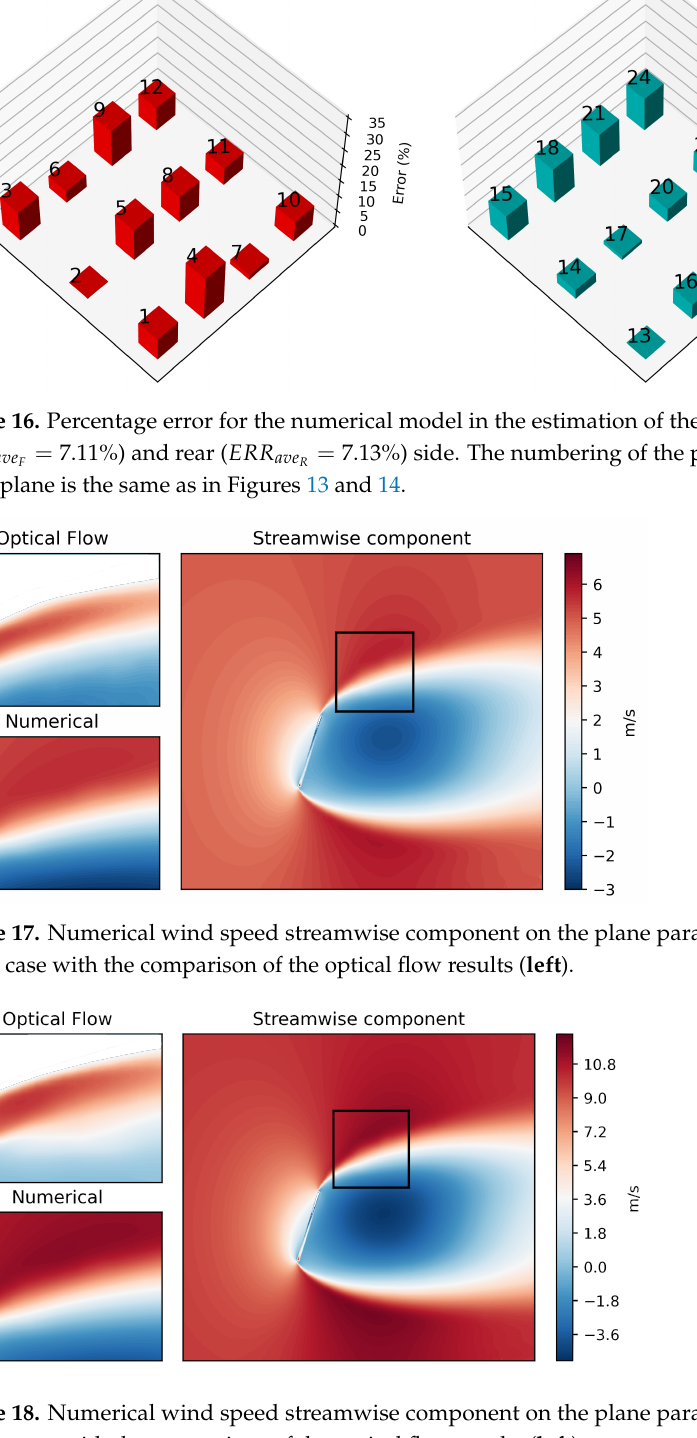
Figure 18. Numerical wind speed streamwise component on the plane parallel to the flow for the 10 m/s case with the comparison of the optical flow results ( left